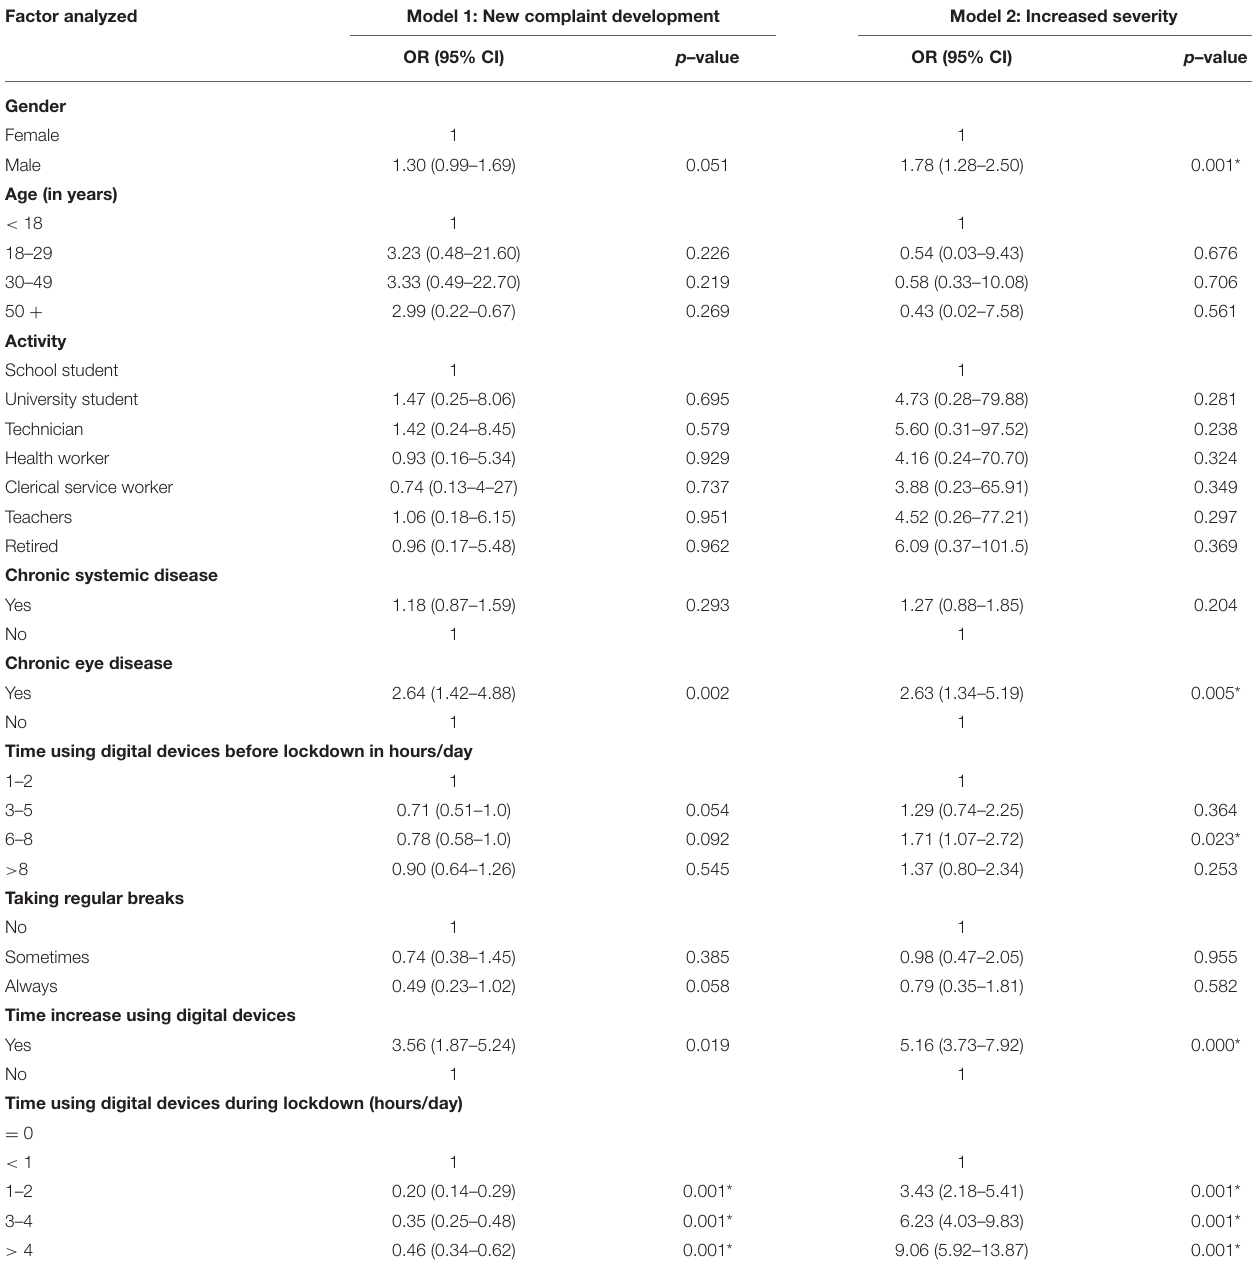
TABLE 4 | Factors associated with emergence of New Eye complaints and increased severity of current eye complaints by logistic